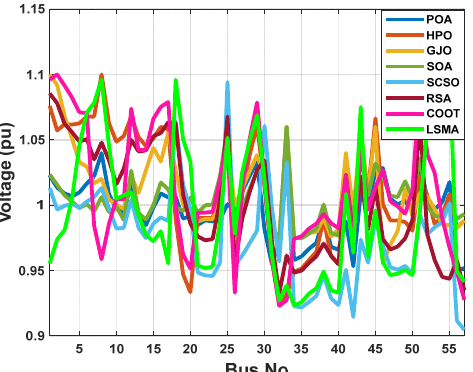
gies in Table 9, which compares solutions obtained using these methods. Table 9. Optimal control variables for the IEEE-57 bus test system for minimizing voltage deviation.